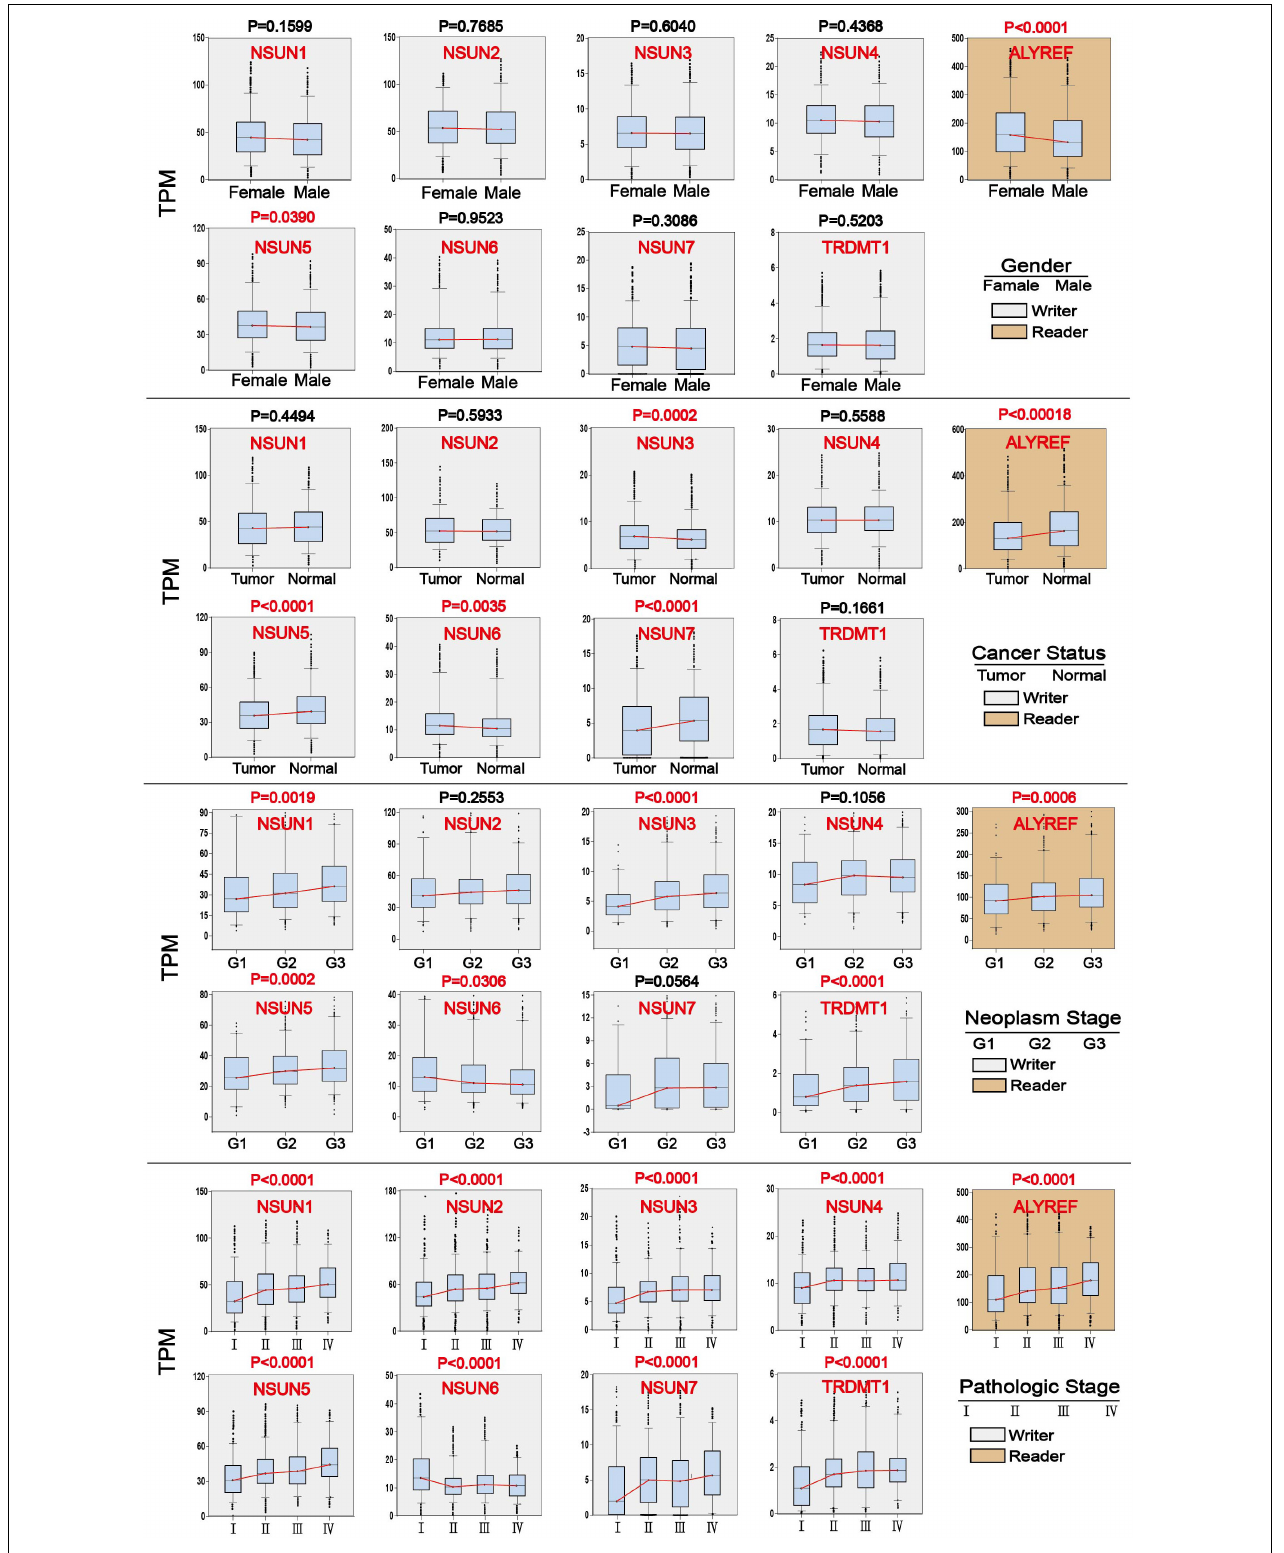
FIGURE 5 | Association of m 5 C regulator expression with clinicopathological parameters in GI cancer. Clinical parameter analysis includes stage of tumor differentiation (G1, G2, and G3), pathological stage, and cancer status, and gender was analyzed by one-way ANOVA.